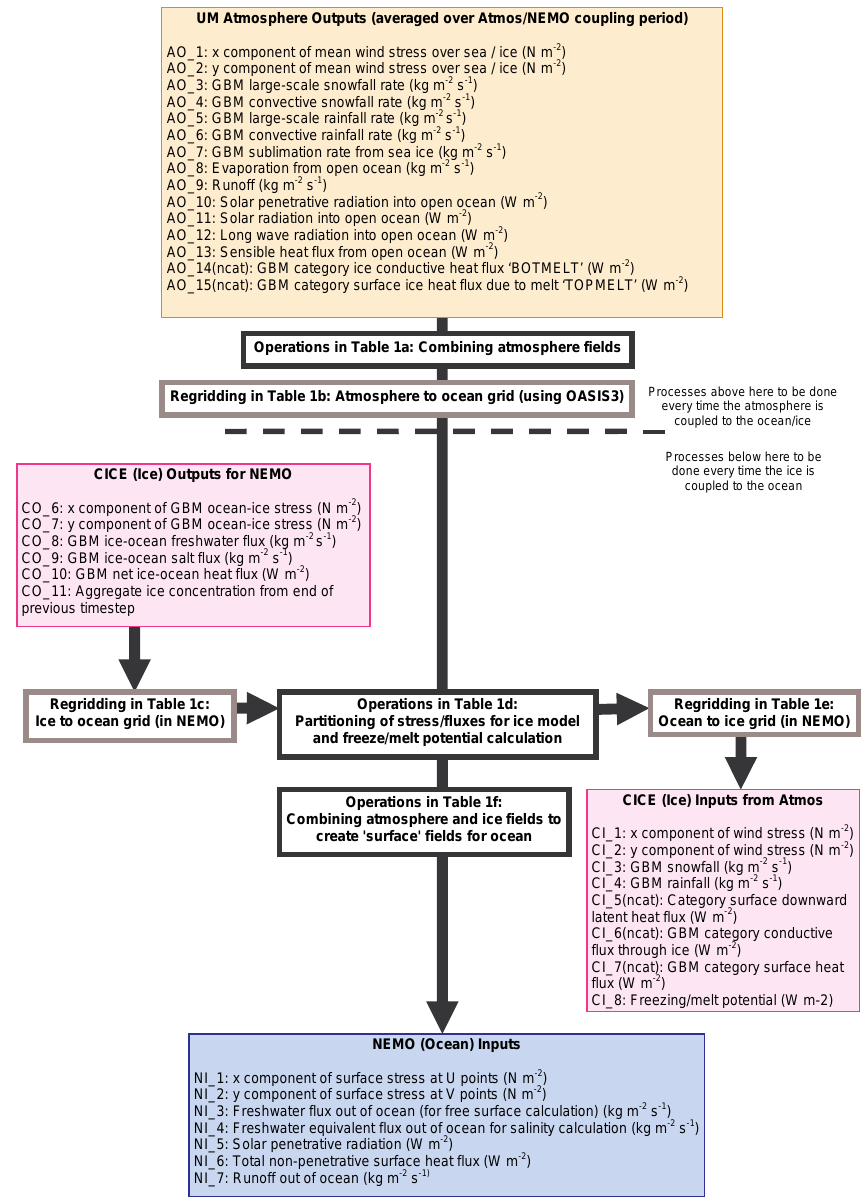
Fig. 4. Flow diagram showing the coupling of the 3 submodels in HadGEM3 in the direction atmosphere to sea ice to ocean. Tables 1a–f detail the operations and regridding shown in the figure. Temporary fields are listed in Table 1g and constants used in the coupling are shown in Table 1h. All fields are two dimensional horizontal fields unless marked “(ncat)”, in which case they have a third dimension of the number of ice thickness categories (currently 5). GBM stands for Grid-Box-Mean. Input and output fields are referenced as XY n where X is (A, N, C) for (Atmosphere, NEMO, CICE), Y is (I,O) for (Input, Output) and n indicates the number of the field. Temporary variables used during the coupling are referenced as Tn XZ where n is the number, X is the model, and Z is (T, U, V) according to the grid points on which these fields are found (see Table